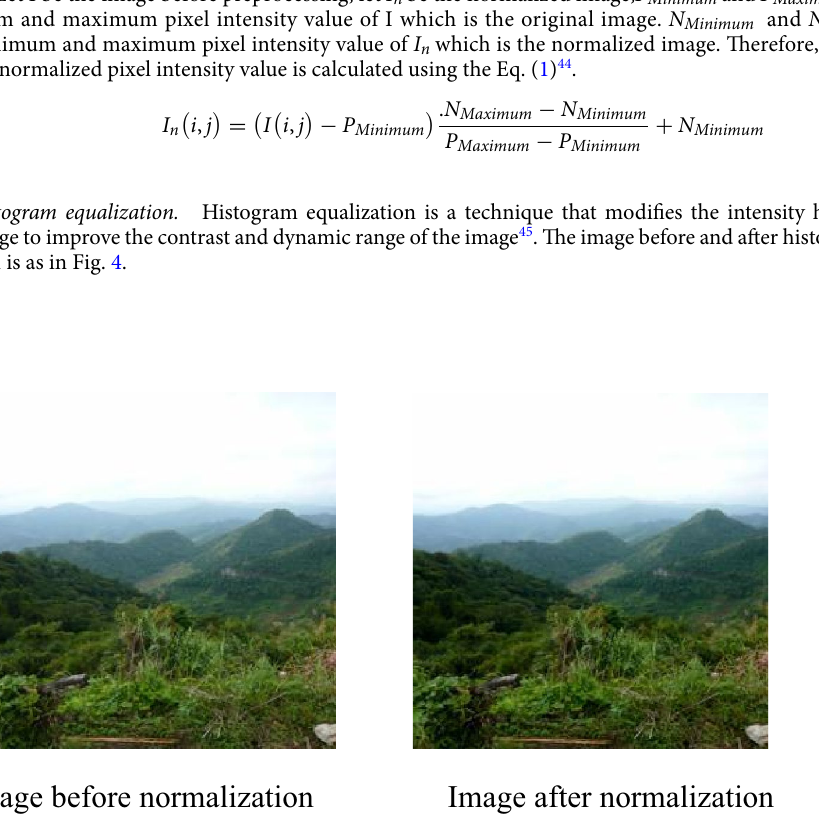
Figure 3. Images before and after